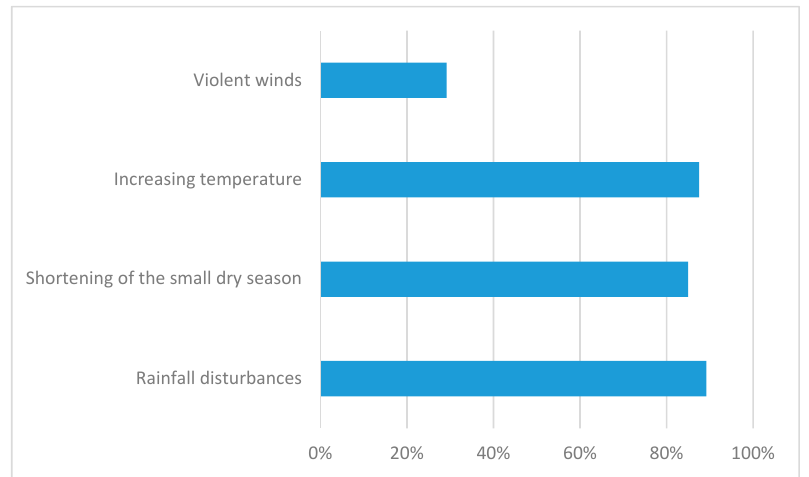
Figure 2. Farmers’ perception of climate change. Environments 2018 , 5 , 15